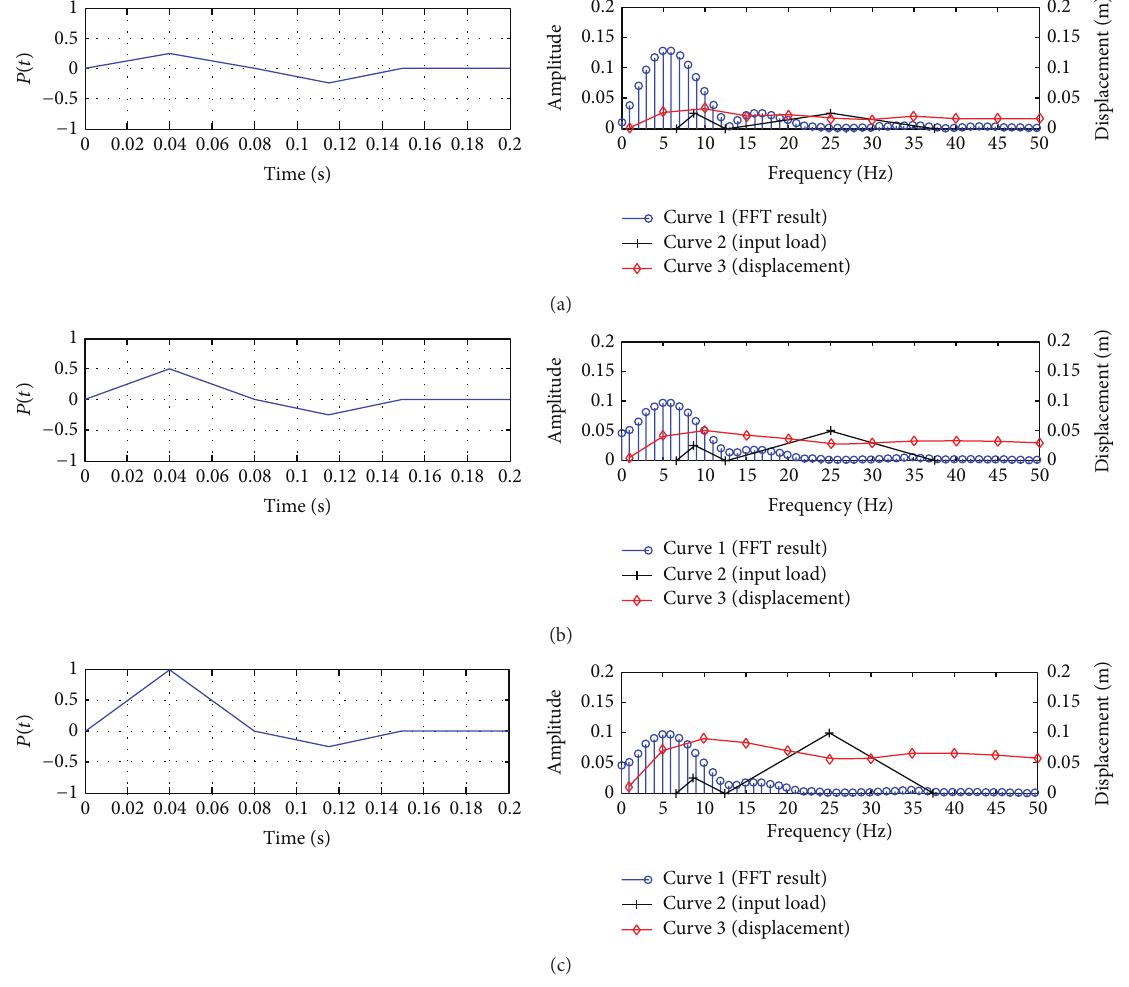
Figure 6: Fast Fourier Transform analysis considering the magnitude of maximum load in positive pressure phase. (a) Standard data. (b) Increasing the 2 times of positive maximum load. (c) Increasing the 4 times of positive maximum load.